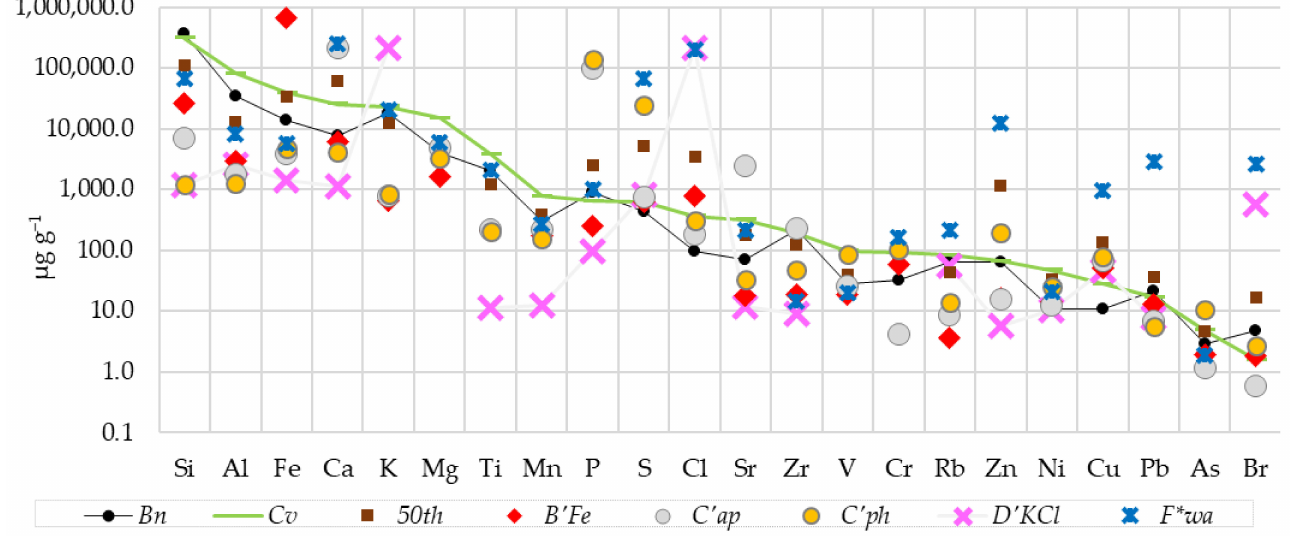
Figure 3. Comparison of native topsoil background values ( Bn ) with: Cv —Clarke values [50]; 50th —median elemental contents in dust of the city; elemental contents in stevedored dust of: B’Fe –iron ore; C’ap —apatite; C’ph —phosphorite, D’KCl —potassium fertilizers; F*wa —elemental contents in waste incineration